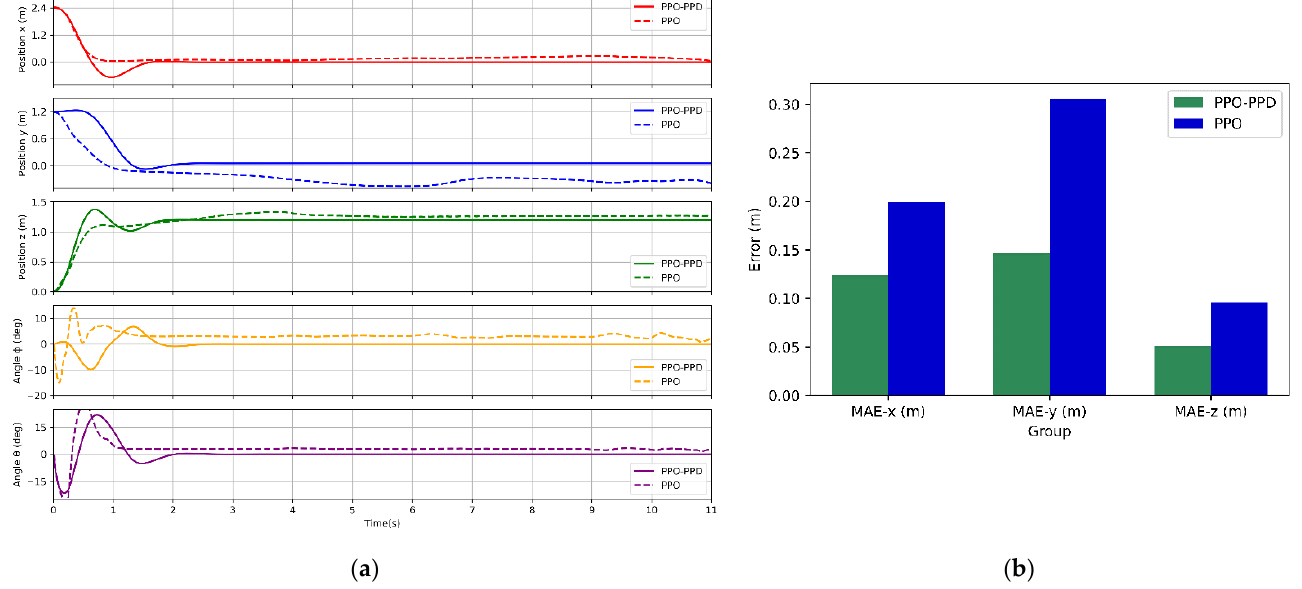
Figure 11. ( a ) Position and attitude control responses of the learned policies from PPO-PPD and PPO. ( b ) Average absolute steady-state error of PPO-PPD and PPO.